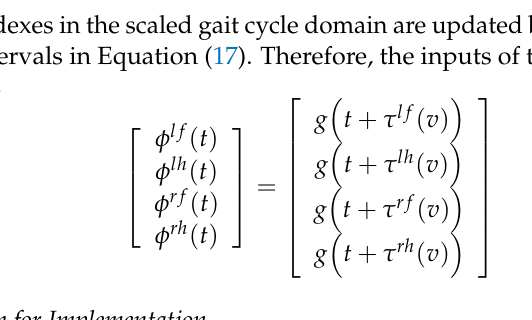
Figure 9. Rates of the input of cyclic basis functions; t 0 = ω − 1 swing and stance periods, and T cycle means the total period of one gait